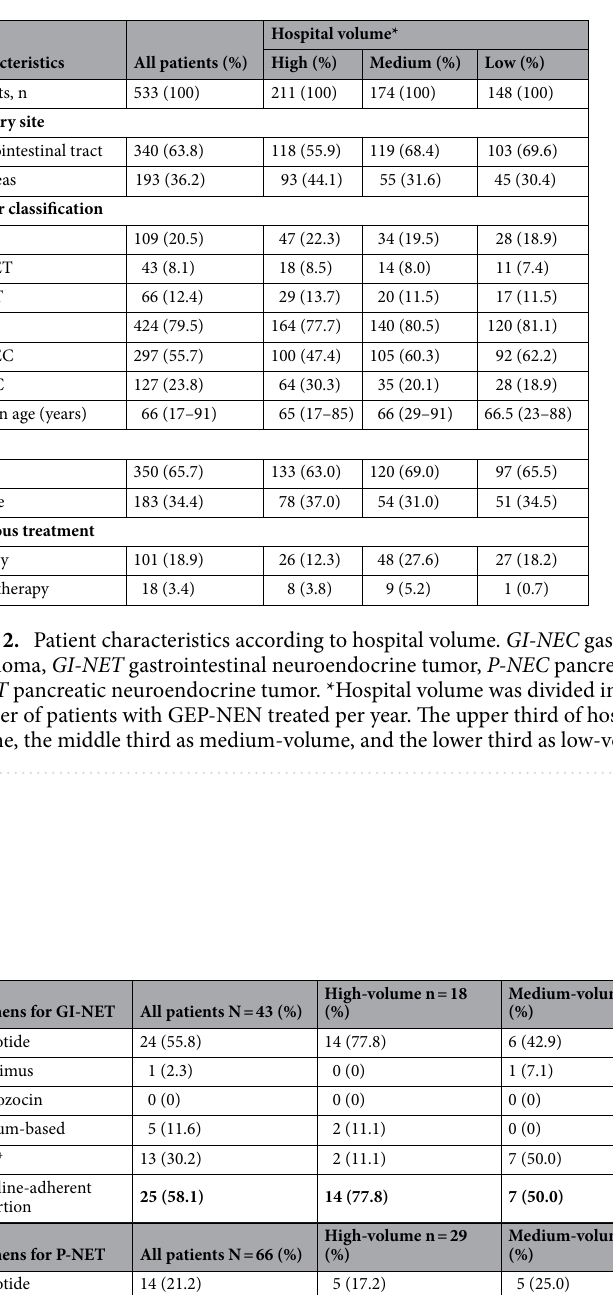
Table 3. Real-world selection of first-line systemic therapy regimens for patients with GEP-NET according to hospital volume subgroup. GEP gastroenteropancreatic; GI-NET gastrointestinal neuroendocrine tumor, P-NET pancreatic neuroendocrine tumor. *Epirubicin, epirubicin + cyclophosphamide + fluorouracil, epirubicin + mitomycin, capecitabine, tegafur/uracil, octreotide + dacarbazine, octreotide + epirubicin + fluorouracil + mitomycin. † Epirubicin, cisplatin, cisplatin + etoposide, cisplatin + irinotecan, S-1, epirubicin + octreotide, cisplatin + irinotecan + octreotide, gemcitabine + cisplatin + irinotecan + octreotide, gemcitabine + everolimus + octreotide, gemcitabine + fluorouracil + irinotecan + oxaliplatin, sunitinib + cisplatin. Significant values are in bold.